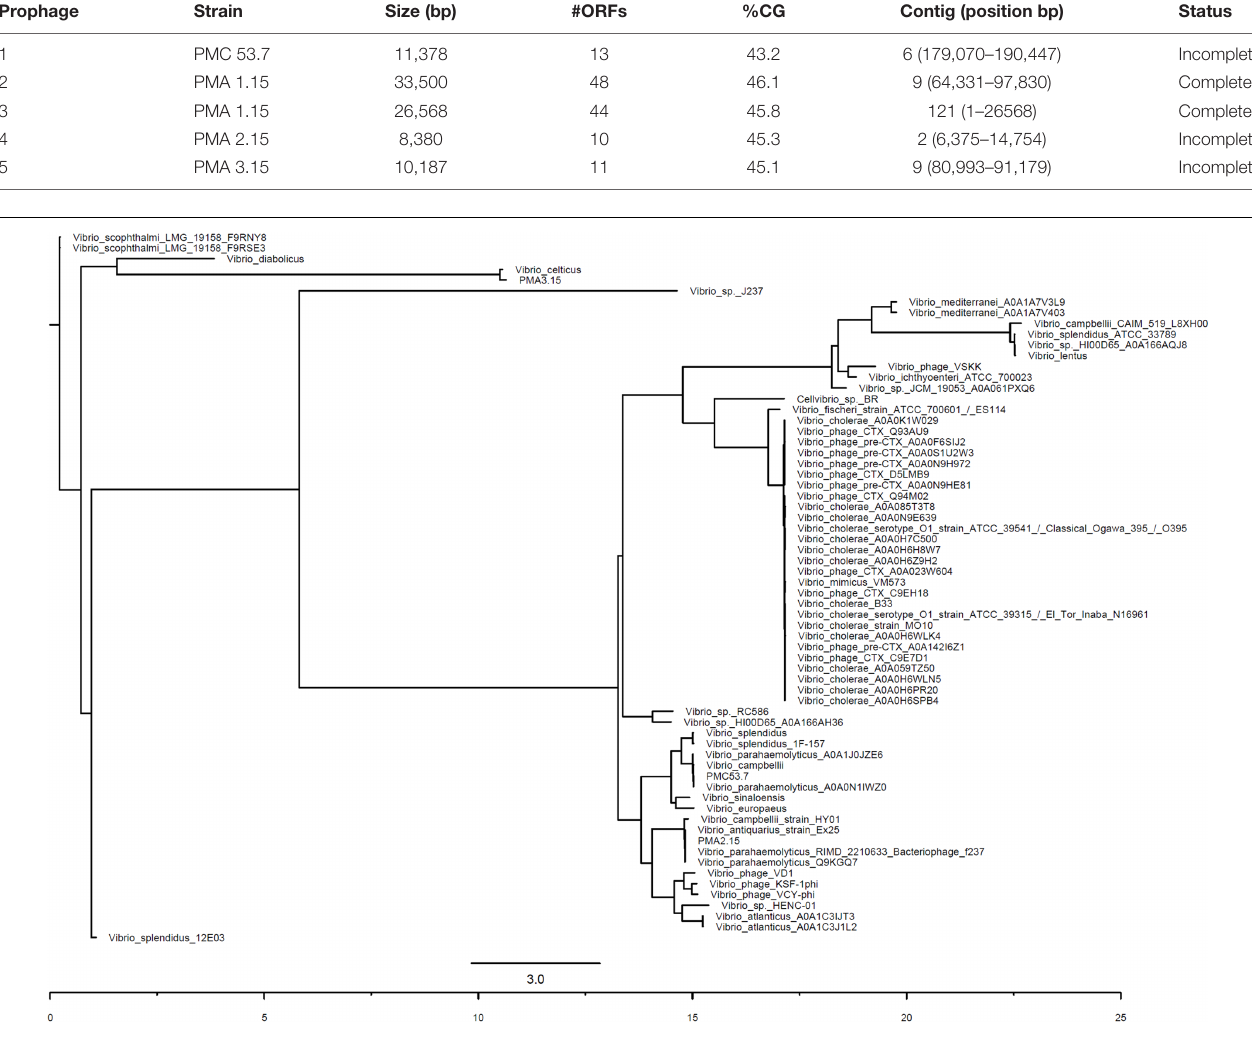
Interestingly, the environmental strains PMA 1.15, PMA